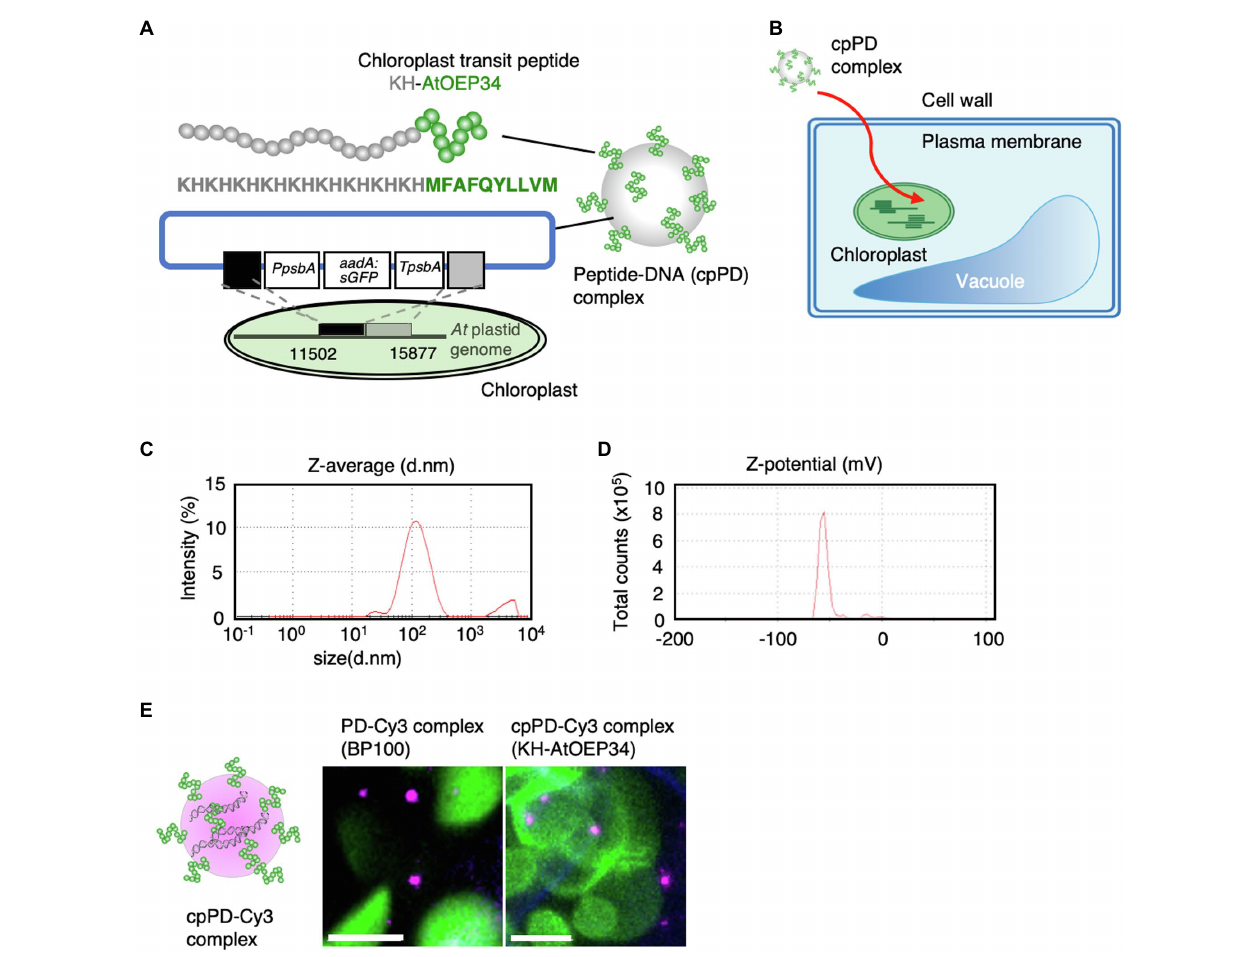
FIGURE 1 | Characterization of the peptide–DNA complex used in this study. (A) Schematic diagram of the peptide–DNA complex KH-AtOEP34–pDNA (cpPD complex) used in this study. The protein sequence of the KH-AtOEP34 peptide is shown in gray (KH) or green (AtOEP34). Plasmid DNA used for integrating exogenous DNA into Arabidopsis thaliana ( At ) plastid genome is shown below. Each box represents DNA fragments, PpsbA , promoter of psbA; aadA-sGFP , a sequence coding aminoglycoside adenyltransferase ( aadA ) fused to sGFP ; TpsbA , terminator sequence of psbA ; black and gray boxes; sequence used for integration into chloroplast genome. (B) Schematic diagram of the path of cpPD complexes from the extracellular space of a leaf cell to the chloroplast stroma. (C,D) Z-average (C) and Z-potential (D) of cpPD complexes in solution. (E) Left, schematic diagram of the KH-AtOEP34–pDNA complex labeled with Cy3 (cpPD- Cy3 complex). Right, representative images of PD-Cy3 complexes (BP100) and cpPD-Cy3 complexes in leaf mesophyll cells. Scale bars denote 10 μ